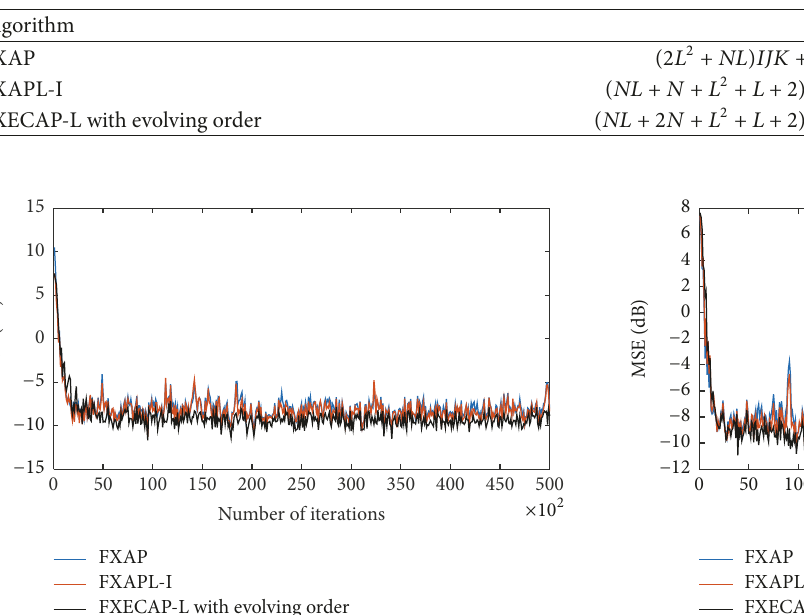
Table 2: Memory requirements for the FXAP, FXAPL-I, and FXECAP-L algorithms.